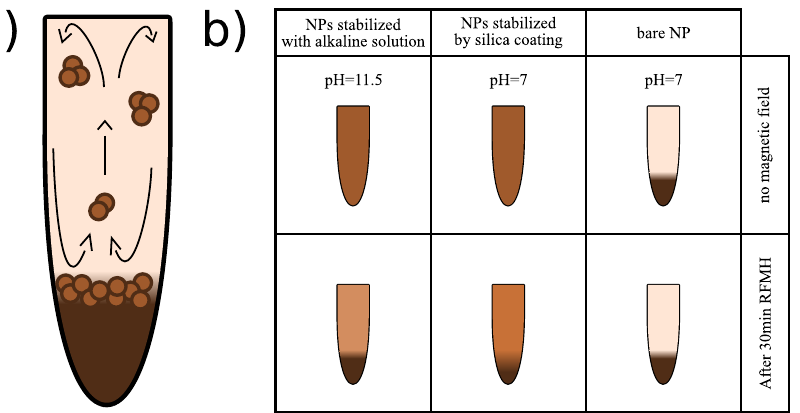
Figure 1. ( a ) Diagram of the circulation of magnetic nanoparticles in an aqueous solution subjected to a RF magnetic field. ( b ) The schematic drawings in the top row illustrate stable colloidal suspen- sions of bare nanoparticles at pH = 11.5, silica-stabilized nanoparticles at pH = 7, and the unstable suspension of bare nanoparticles at pH = 7. The lower schematic drawings show the sedimentation effect of magnetic nanoparticles as a result of exposure to an external RF magnetic